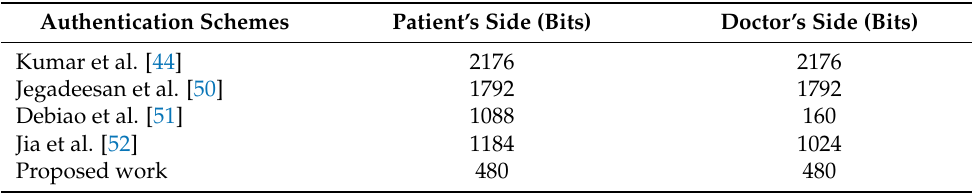
Table 3. Storage overhead for analyzed authentication